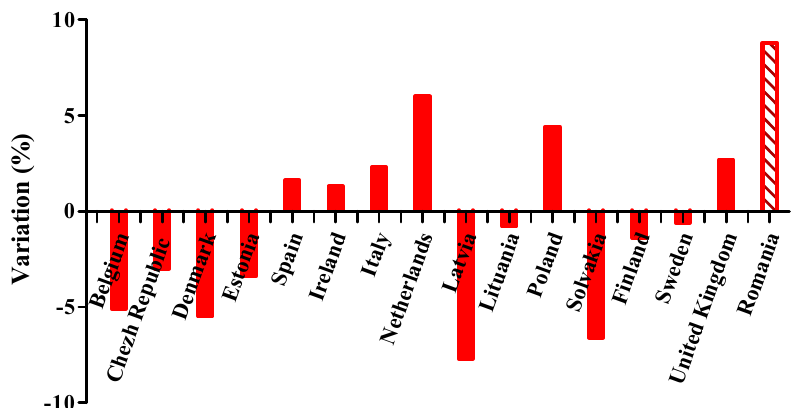
Figure 1. Variation of the percentage of diabetes funds in the total health expenditure in 16 EU countries (2011 vs. 2007).